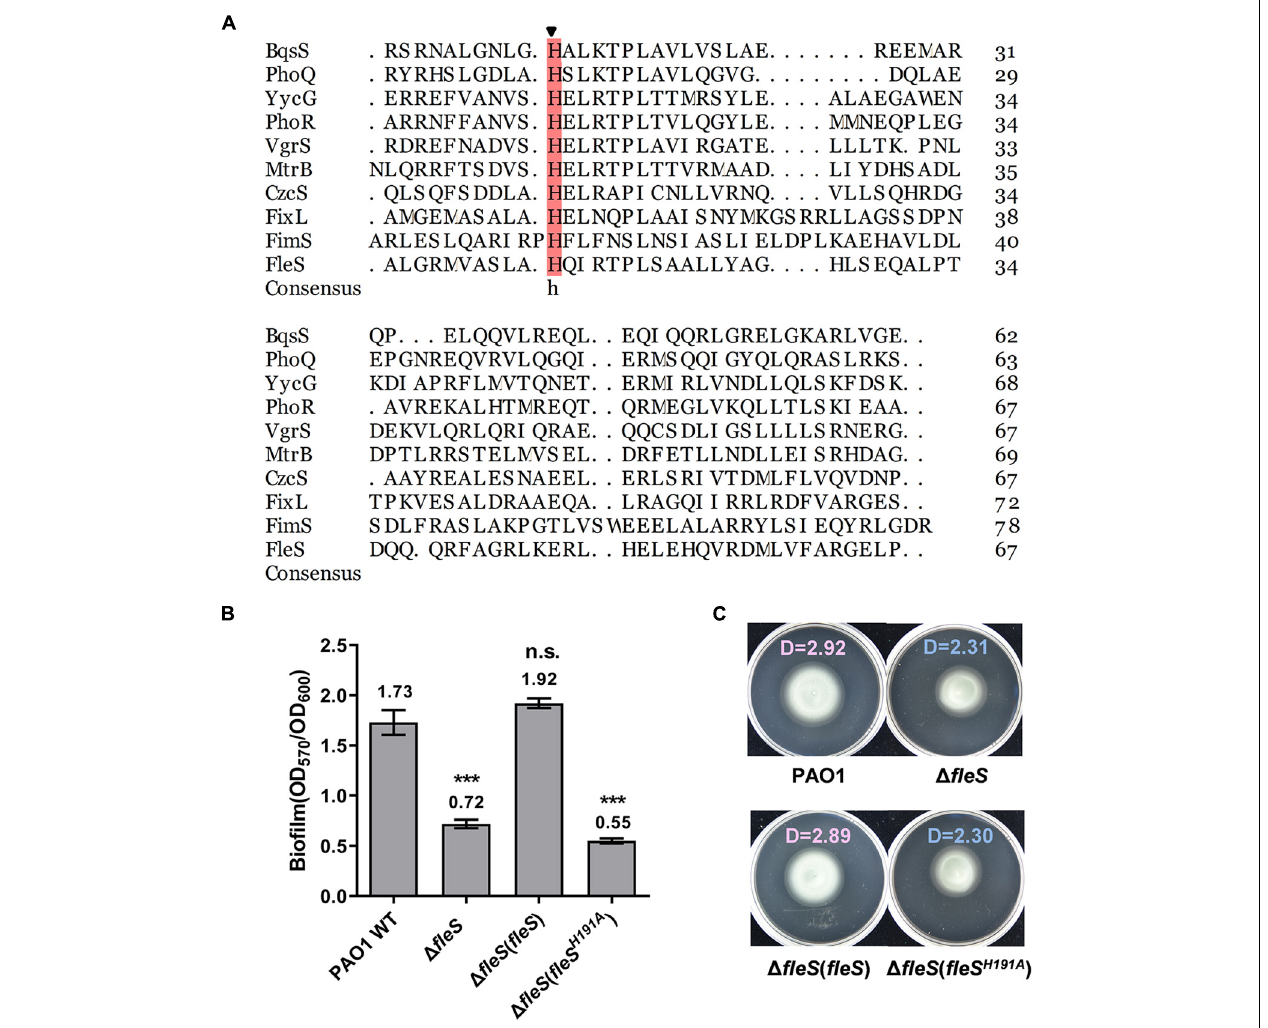
FIGURE 3 | The histidine at the position of 191 in FleS is conserved with other histidine kinase and important in FleS signaling. (A) Sequence alignment of the HisKA domain of FleS with nine canonical HisKA domains from YycG (WP_023482385.1), PhoR (WP_003121316.1), FixL (WP_011119443.1), VgrS